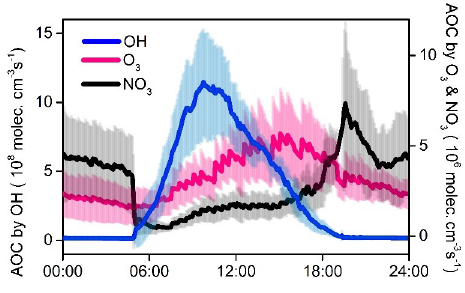
Figure 9. Model-calculated average oxidation capacity of OH, O 3 , and NO 3 during the summertime O 3 pollution episodes. The error bars indicate the standard deviations of the mean.